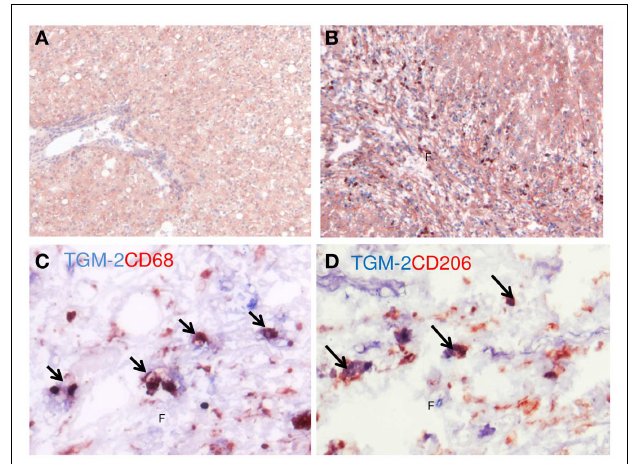
FIGURE 8 | LocalizationTGM-2 (M2) in human livers . (A,B) Immunohistochemical localization ofTGM-2 in normal (A) and cirrhotic (B) human livers. Note the presence of the strongly stained cells in the fibrotic matrix (F) . (C) Co-localization ofTGM-2 (blue staining) and CD68 (red staining). (D) Co-localization ofTGM-2 (blue staining) and CD206 (red staining). Arrows indicate co-localization. Magnifications: 100 × (A,B) and 400 × (C,D) . N = 5 cirrhotic human livers, N = 6 normal human